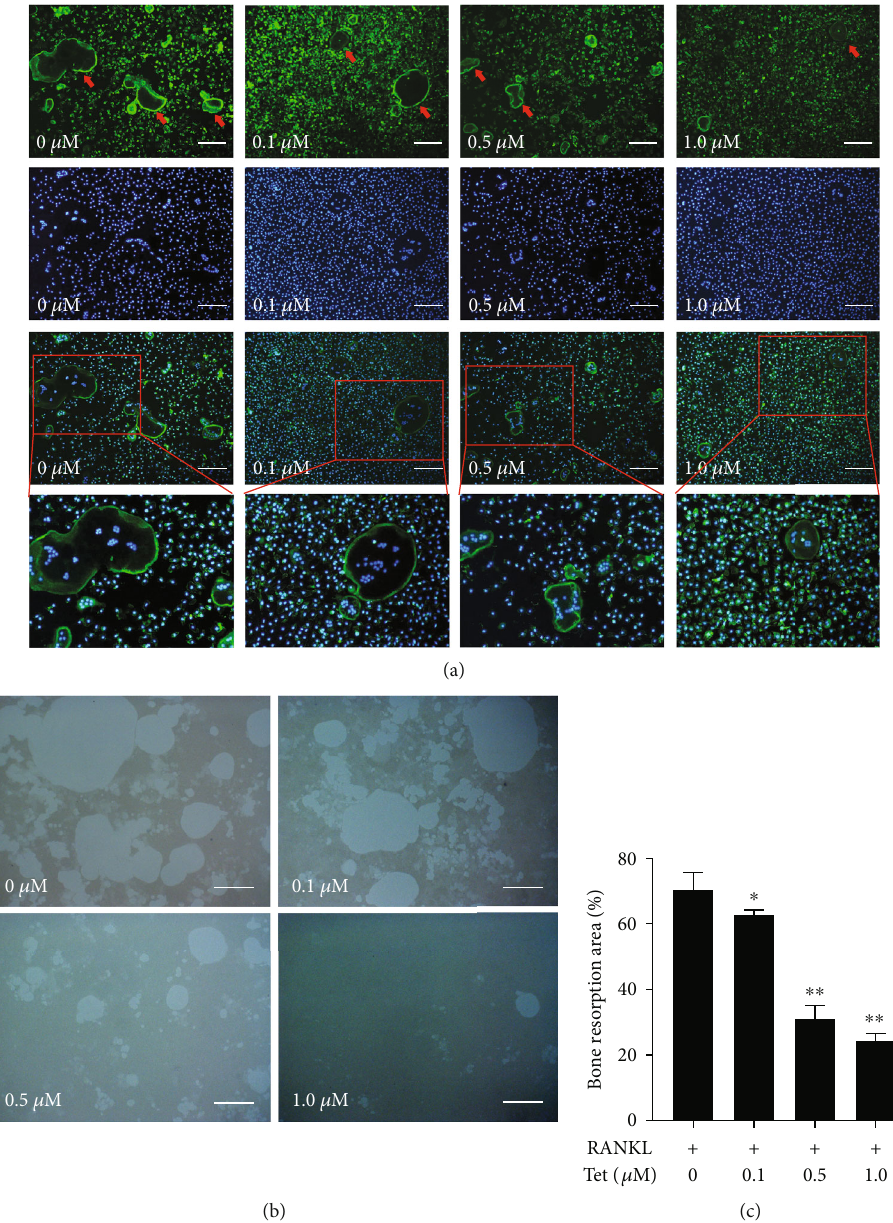
Figure 5: Tetrandrine (Tet) decreases osteoclast bone resorption and the formation of F-actin rings. (a) F-actin rings and nuclei were observed under a confocal microscope ( scale bar = 100 μ m ). (b) Images of the bone resorption pits in each group ( scale bar = 100 μ m ). (c) Quanti fi cation of bone resorption area ( ∗ p < 0 : 05 , ∗∗ p < 0 : 01 compared with the control group; n = 4 per group). Data are the means of at least three independent experiments with similar results. The red arrows indicate the F-actin